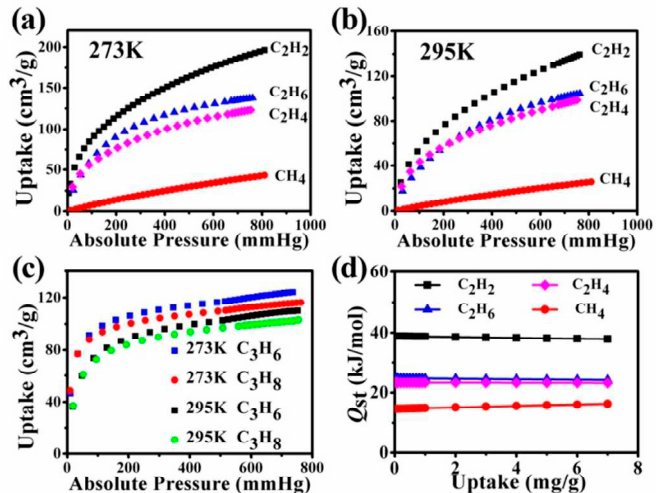
Figure 6. Hydrocarbon adsorption of UPC-21. The C 2 H 2 , C 2 H 4 , C 2 H 6 and CH 4 adsorption isotherms for UPC-21 at 273 K ( a ); and 295 K ( b ); ( c ) The C 3 H 6 and C 3 H 8 adsorption isotherms for UPC-21 at 273 K and 295 K; ( d ) The isosteric heat of adsorption for C 2 H 2 , C 2 H 4 , C 2 H 6 and CH 4 Reprinted with permission [65] Copyright 2016, Royal Society of Chemistry.